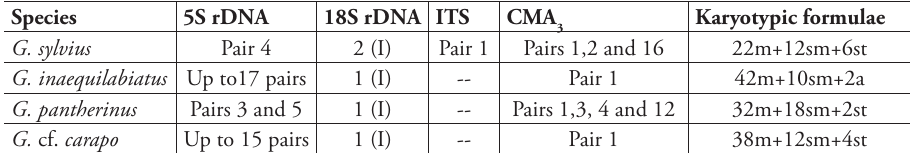
Figure 5a–d. Karyotype of G . cf. carapo after ( a ) conventional Giemsa staining, ( b ) C-banding, ( c ) CMA fluorochrome staining, ( d ) double FISH with 5S rDNA (red) and 18S rDNA (green) probes. Bar = Table 2. Cytogenetic data on four species of Gymnotus . ITS – Interstitial Telomeric Sites; (I) – Interstitial mark.